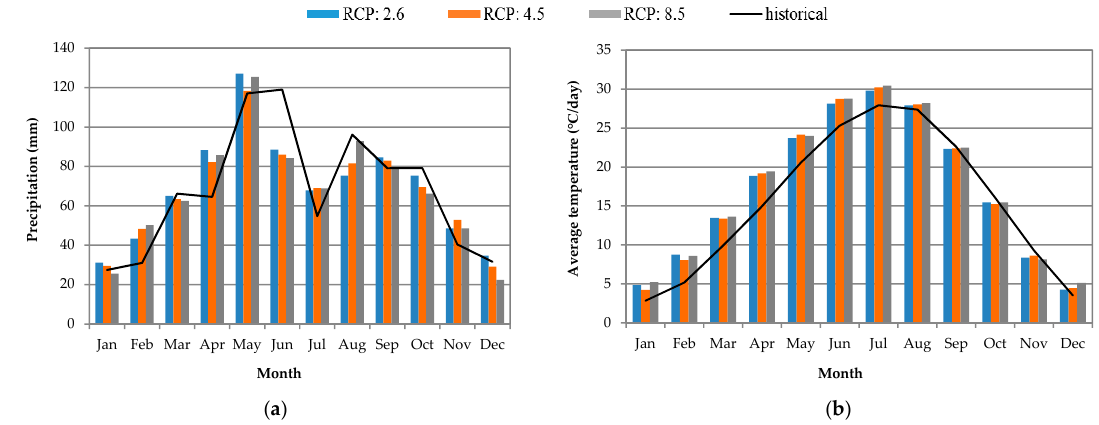
Figure 5. Average monthly precipitation ( a ) and average monthly temperature ( b ) under the historical (1986–2010) and future (2016–2040) climate. For future climate, values are presented as an average of all three GCMs for each climate scenario (RCP).